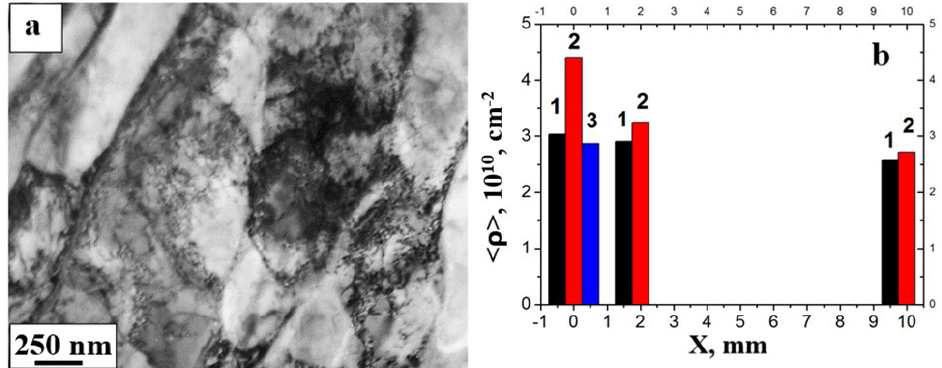
Figure 7. Dislocation substructure of rails observed in the layer at a depth of 10 mm from fillet surface (a); b – diagram of scalar dislocation density gradient (X - distance from working fillet surface); 1 - degenerate pearlite + fractured pearlite; 2 - lamellar pearlite; 3 - ferrite-carbide mixture.